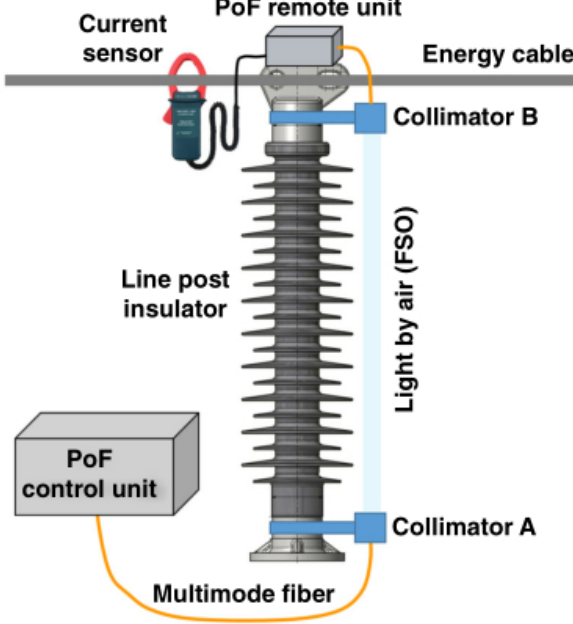
Figure 22. PoF/OWC system and its components [78]. Figure 22. PoF / OWC system and its components